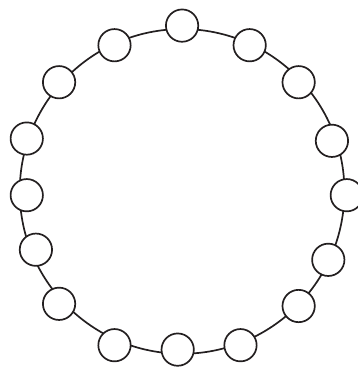
Figure 2. Local topology.